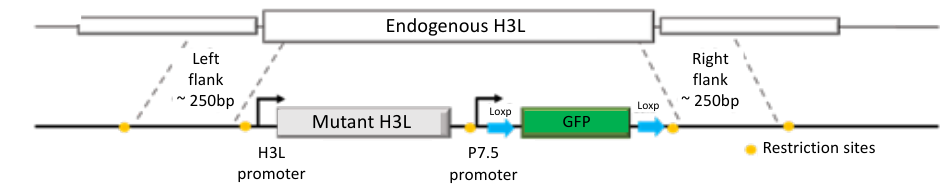
Figure 1. Schematic diagrams for an experimentally driven B cell epitope deletion strategy. A panel of overlapping synthetic peptide fragments spanning the full sequence of H3L viral protein is synthesized. The peptides are then tested for immune recognition, typically using in vitro ELISA with polyclonal anti-vaccinia viral (VV) antibodies. Identified immunogenic peptides are subjected to